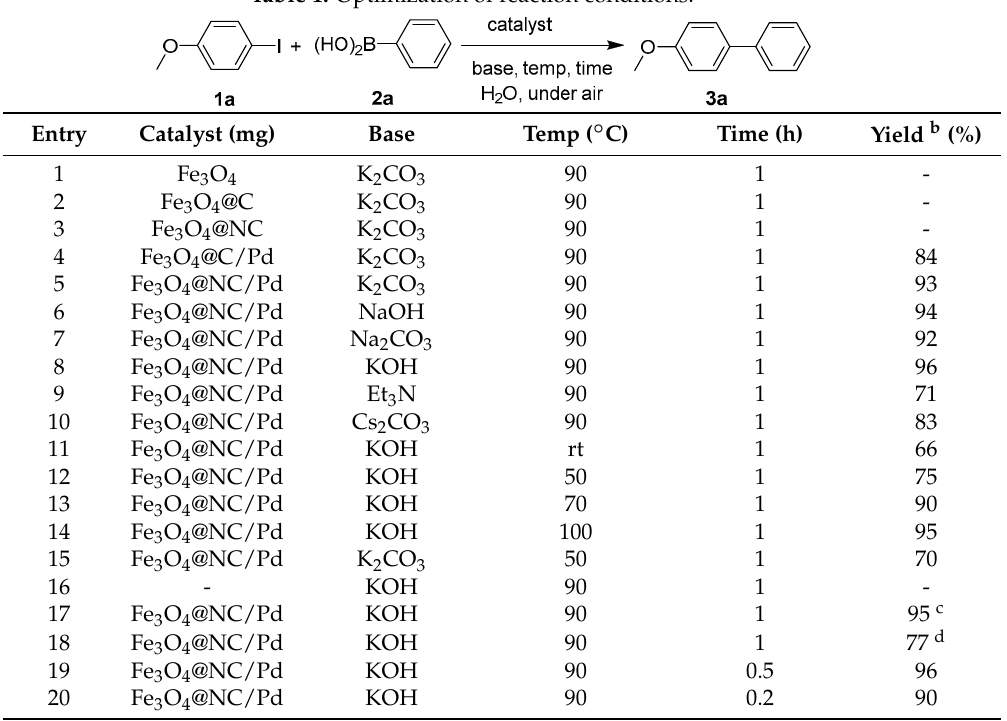
Table 1. Optimization of reaction conditions. a.